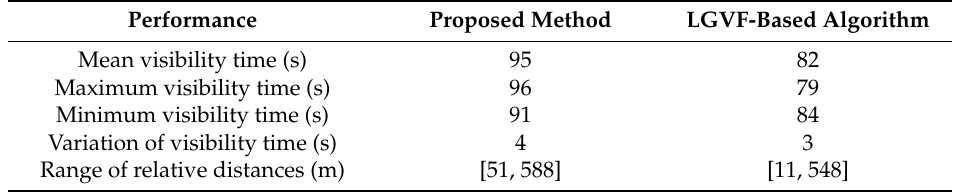
Table 3. Statistics results of the tracking performances for scenario 2.